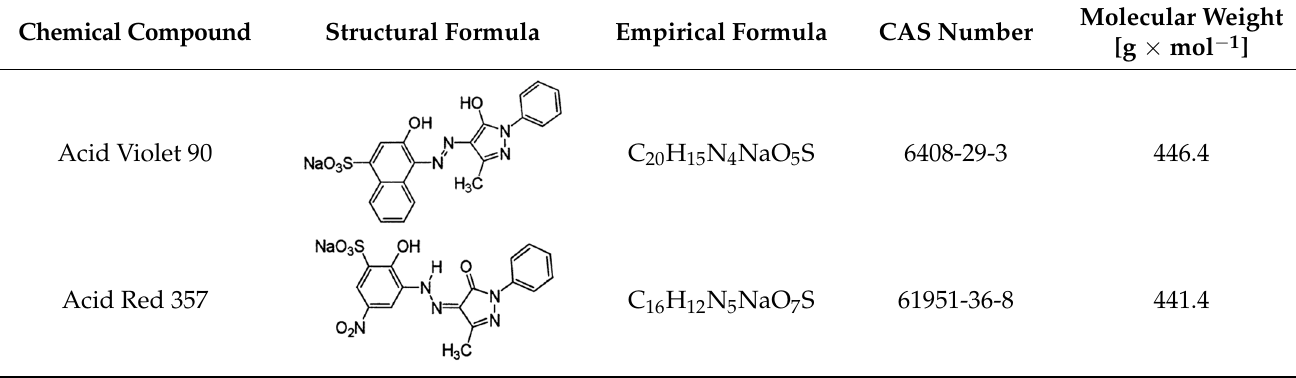
Table 1. Specification of the dyes used in the research [31,32]. Chemical Compound